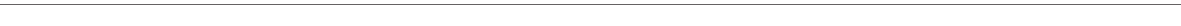
FigUre 2 | mTOR complex 2 is critical for follicular helper CD4 + T (T FH ) differentiation during acute viral infection. (a–D) Cd4- Cre Rictor fl/fl mice ( Rictor − / − ) and littermates Rictor fl/fl (WT) mice were infected with lymphocytic choriomeningitis virus (LCMV) Armstrong, and CD4 + T cell responses were assessed in spleen at day 8 after infection. (a) Flow cytometry of T FH (SLAM lo CXCR5 + ) and T H 1 (SLAM hi CXCR5 − ) cells among gp66 tetramer-positive CD4 + T (gp66 + CD4 + ) cells of Rictor − / − (top) and WT mice (bottom) (left), and summary of the frequency (top) and cell number (bottom) (right) ( n = 8 mice per group). (B) Representative flow cytometry plots showing the expression levels of CXCR5, Bcl-6, PD-1, and ICOS on tetramer-positive T FH cells as in (a) from Rictor − / − and WT mice (top), and summary of the mean fluorescence intensity (bottom) ( n = 8 mice per group). (c) Flow cytometry of bulk activated T FH (GITR lo CD44 hi CXCR5 + ) and T H 1 (GITR lo CD44 hi CXCR5 − ) cells of Rictor − / − (top) and WT mice (bottom) (left), and summary of the frequency (top) and cell number (bottom) (right) ( n = 8 mice per group). (D) Flow cytometry of germinal center T FH cells (Bcl6 hi cMaf hi ) among bulk activated T FH cells (GITR lo CD44 hi CXCR5 + ) of Rictor − / − (top) and WT mice (bottom) (left), and summary of the frequency (top) and cell number (bottom) (right) ( n = 4–5 mice per group). (e,F) Flow cytometry of CD4 + T cell responses in the spleen of KO versus WT bone marrow (BM) chimeras at 8 days after LCMV infection. KO BM chimeras were generated with a mixture of BM cells from Rictor − / − (CD45.2 + ) and C57BL/6J (WT) (CD45.1 + ) mice, and WT BM chimeras were reconstituted with a mixture of BM cells from Rictor fl/fl (CD45.2 + ) and C57BL/6J (WT) (CD45.1 + ) mice. (e) Representative flow cytometry plots showing competitive contributions by CD45.2 + cells to the total CD4 + , gp66 + CD4 + , gp66 + T FH , and T H 1 cell population in KO and WT BM chimeras (left). Comparison of the contribution of CD45.2 + cells to gp66 + CD4 + versus total CD4 + , gp66 + CD4 + versus gp66 + T FH , and gp66 + CD4 + versus gp66 + T H 1, respectively (right) ( n = 4 mice per group). (F) Expression of CXCR5 and Bcl-6 in KO and WT BM chimeras ( n = 4 mice per group). ns, not significant, * p < 0.05, ** p < 0.01, *** p < 0.001, **** p < 0.0001 [unpaired (a–D) or paired (e,F) two-tailed t -test]. Data are representative of four (a–D) or two (e,F) independent experiments. Error bars are SEM (a–F)